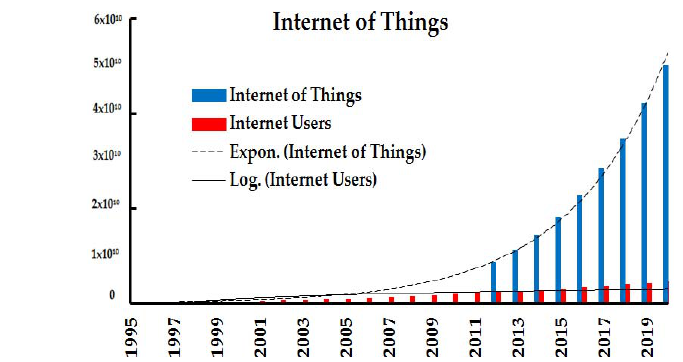
Figure 1 – Internet of Things growth (Ryan & Watson, 2017) Рис . 1 – Рост интернета вещей (Ryan & Watson, 2017) Слика 1 – Раст интернета ствари (Ryan & Watson,